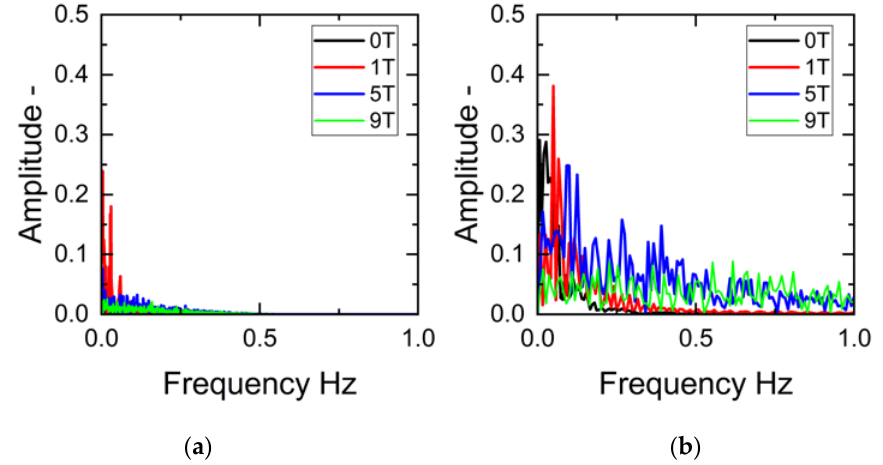
Figure 7. Fast Fourier transform of temperature results for the case with Δ T = 11 °C—( a ) experimental and ( b ) numerical.